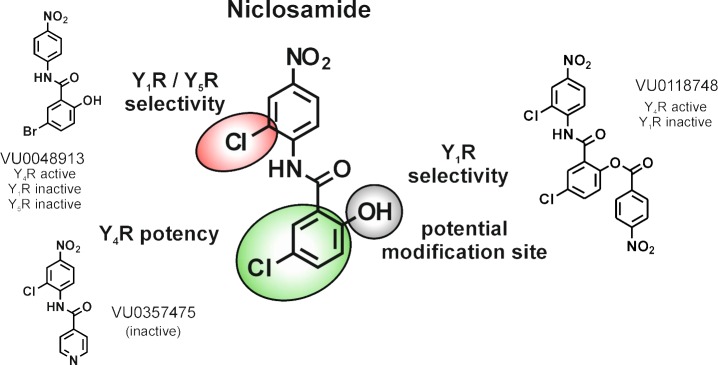
Distinct positions of the Niclosamide scaffold were shown to be relevant for Y4R PAM activity and YR selectivity.Substitutions in the benzoyl ring are important for Y4R potency (green), and offer a potential modification site (grey). Modifications in the aniline ring engender selectivity towards Y1R / Y5R subtype (red).